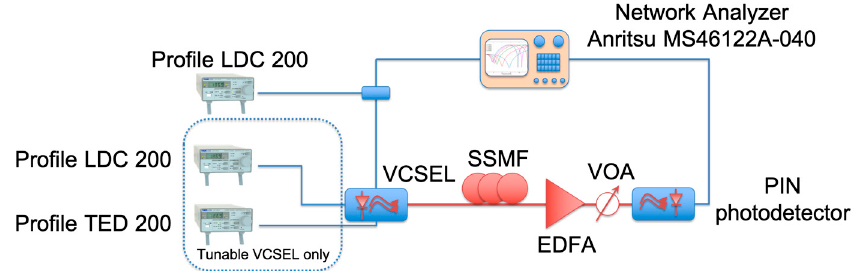
Figure 1. Experimental setup for chirp parameters measurement.